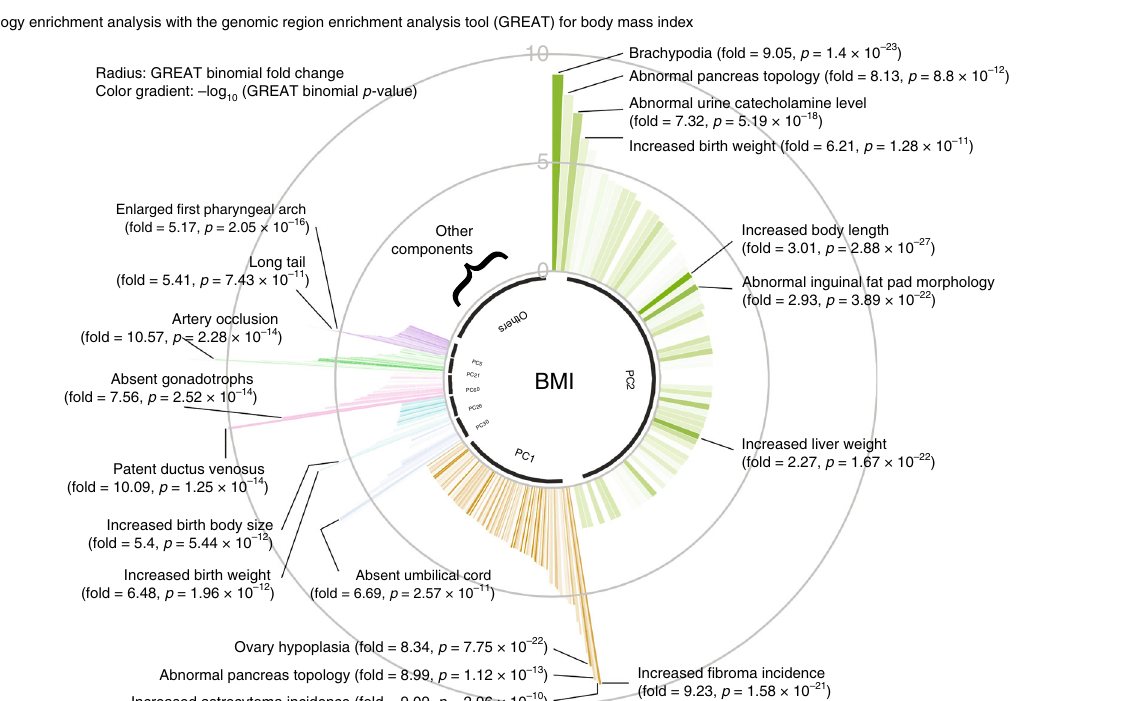
To test the speci fi city of the enriched ontology terms while considering the correlation structure within ontology terms, we took the top fi ve enriched terms for each DeGAs component, obtained the list of genes annotated with these top terms, and measured their pairwise gene set similarity across 100 DeGAs